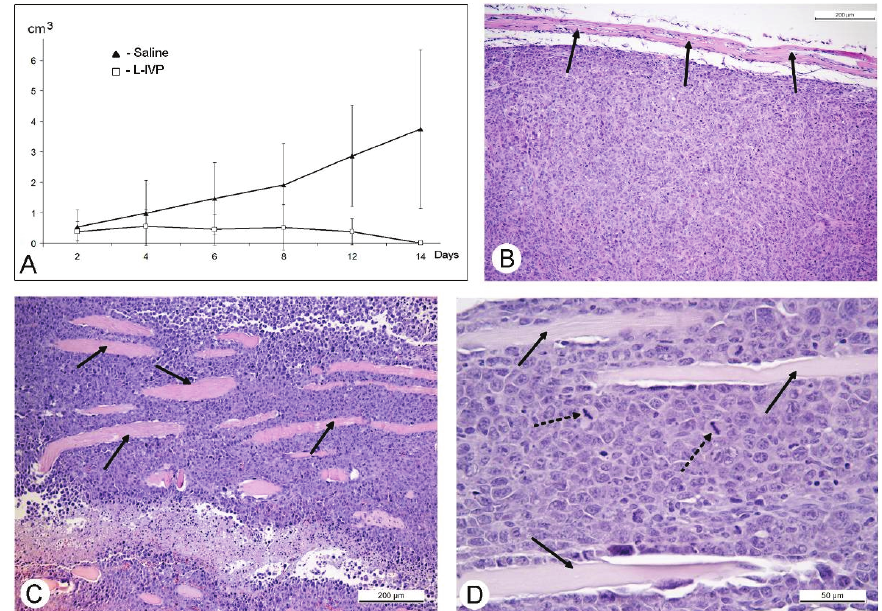
Figure 4. Changes of murine Ehrlich solid carcinoma volume after injection of the L-IVP strain and saline ( A ); period after virus injection is shown on X-axis, tumor volume—on Y-axis. Paraffin section of A431 carcinoma showing capsule (shown by arrows) and smooth outline ( B ); and Ehrlich solid carcinoma ( C , D ). Arrows show fragments of muscle tissue, asterisks show necrotic zone, dotted arrows show mitoses. Hematoxyline and eosin staining.